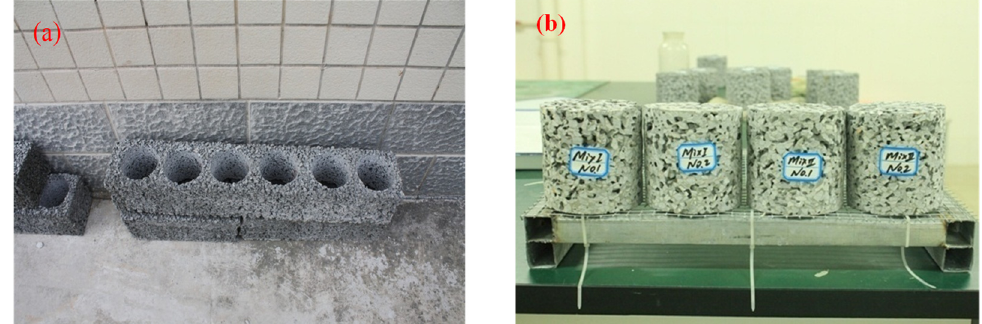
Figure 1. The prepared pervious concrete samples ( a ) cylindrical sample is drilled from the specimen; ( b ) Drilled samples.